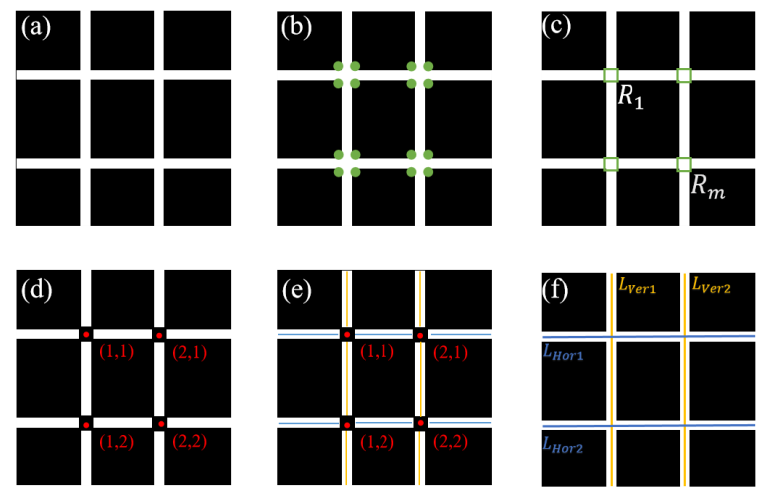
Figure 3. Schematic diagram of the grid stripe feature extraction. ( a ) Input image; ( b ) Corner detection result; ( c ) Intersecting regions; ( d ) Markers; ( e ) Strip centers; ( f ) Horizontal and vertical stripes.